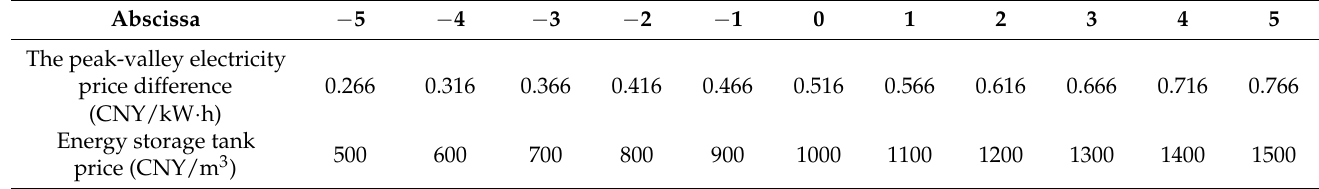
Figure 12. Sensitivity analysis by adjusting the energy storage tank price and peak-valley electricity price difference: ( a ) Case 1; ( b ) Case 2; ( c ) Case 3; ( d ) Case 4. CNY can be converted into USD based on CNY 1 = USD 0.1496 on 1 June 2022. Table 4. The actual values represented by the numbers on the horizontal axis in Figure 12.